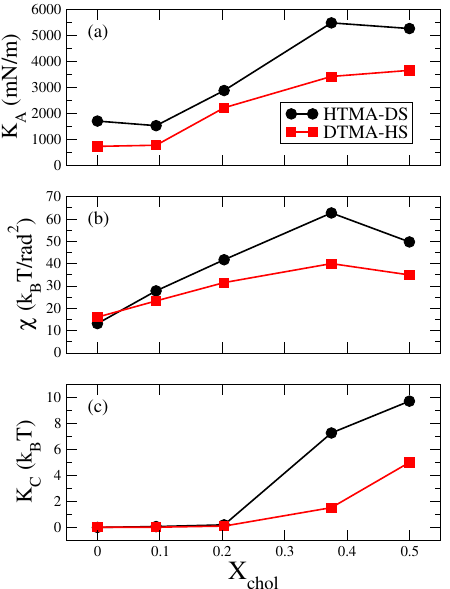
Figure 4. Three mechanical moduli for HTMA-DS-Chol (black circle) and DTMA-HS-Chol (red square) bilayers at various X chol : ( a ) the area compressibility modulus K A , ( b ) molecular tilt modulus χ , and ( c ) bending modulus K C